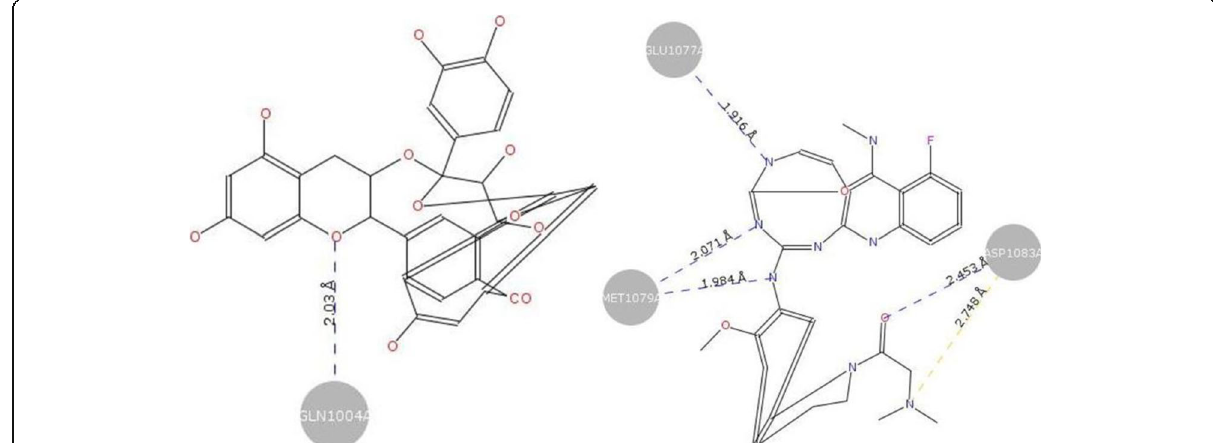
Fig. 6 Hydrogen bonding of procyanidin with cocrystallized ligand-tracked active site in 3EKK (left). Hydrogen bonding and charge interactions of reference ligand with cocrystallized ligand tracked active site in 3EKK